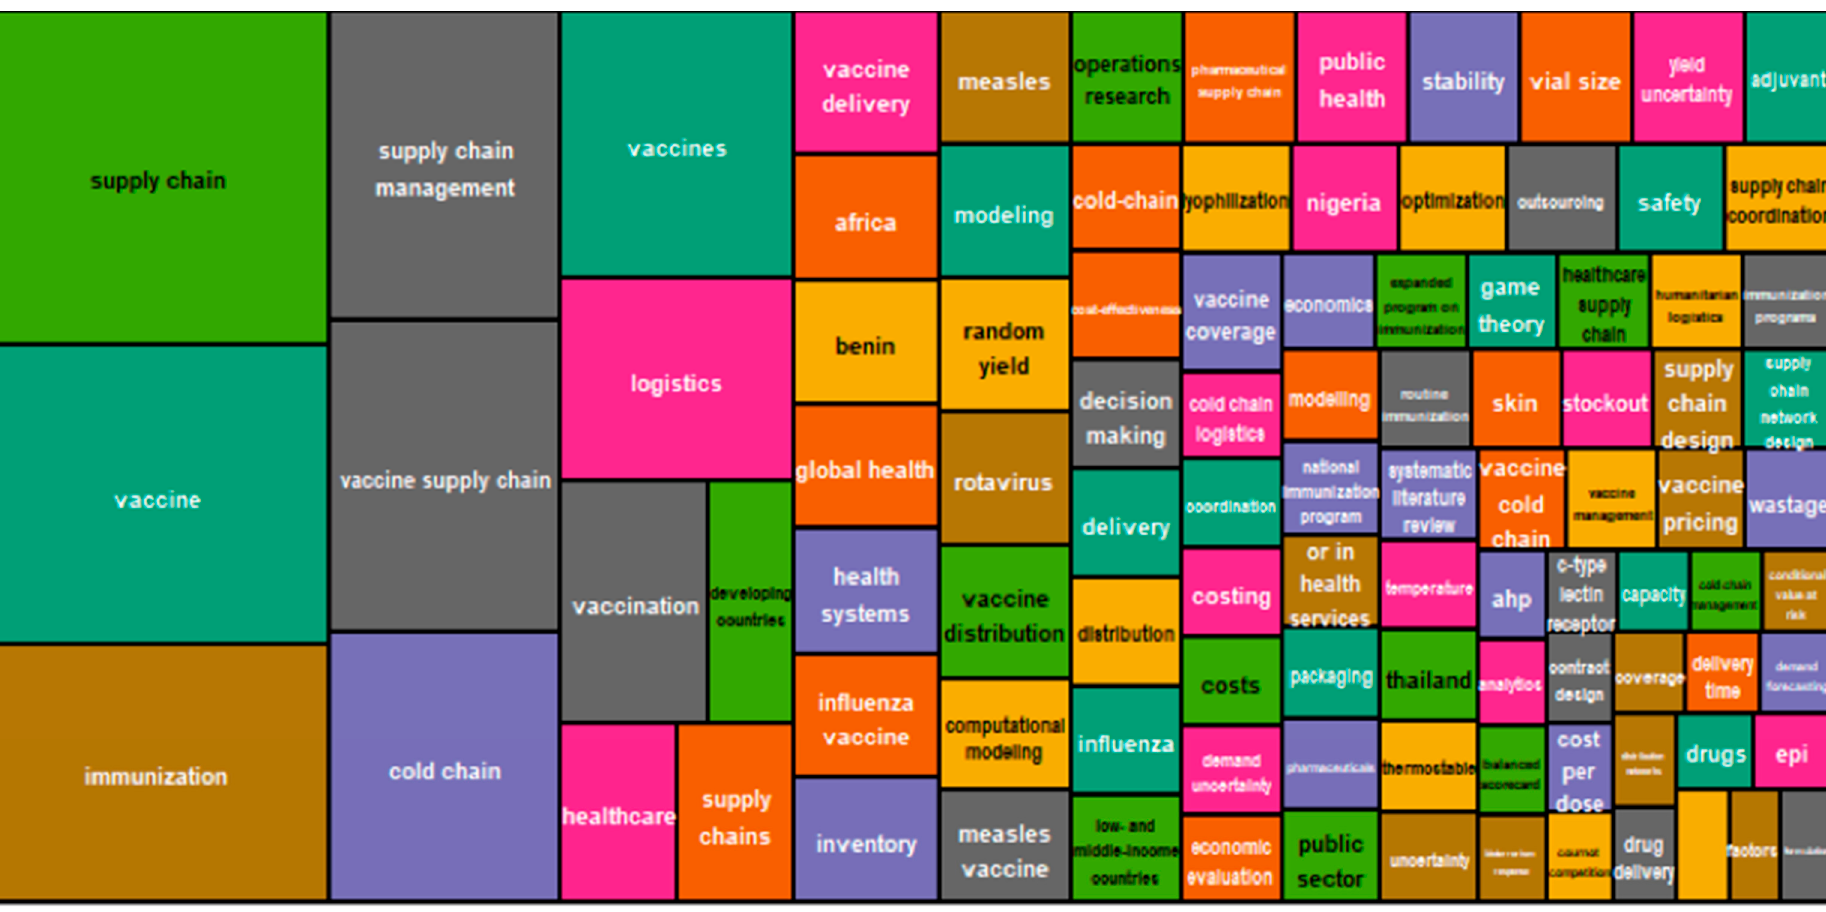
Figure 7. Word tree map.